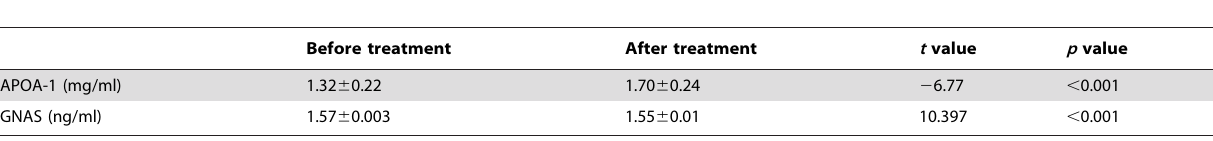
Table 5. APOA-1 and GNAS measured by ELISA before and after 8 weeks of risperidone treatment (N =80).